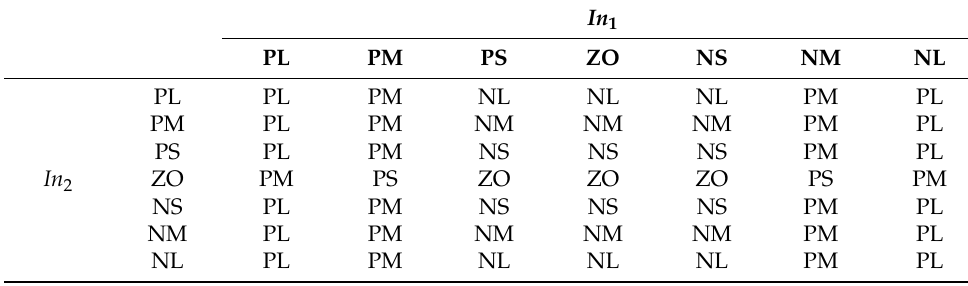
Table 3. Fuzzy control rules for weighting